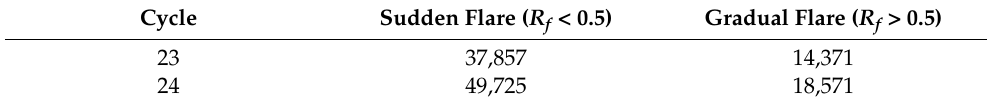
Table 1. Most of these gradual ones happened in the years 2008 and 2009 (the end of SC23 and the beginning of SC24). This indicates that the gradual flare type predominates during the minimum solar activity. Table 1. Several sudden and gradual flares were detected in SC 23 and SC 24. Cycle Sudden Flare ( R f < 0.5) Gradual Flare ( R f > 0.5)